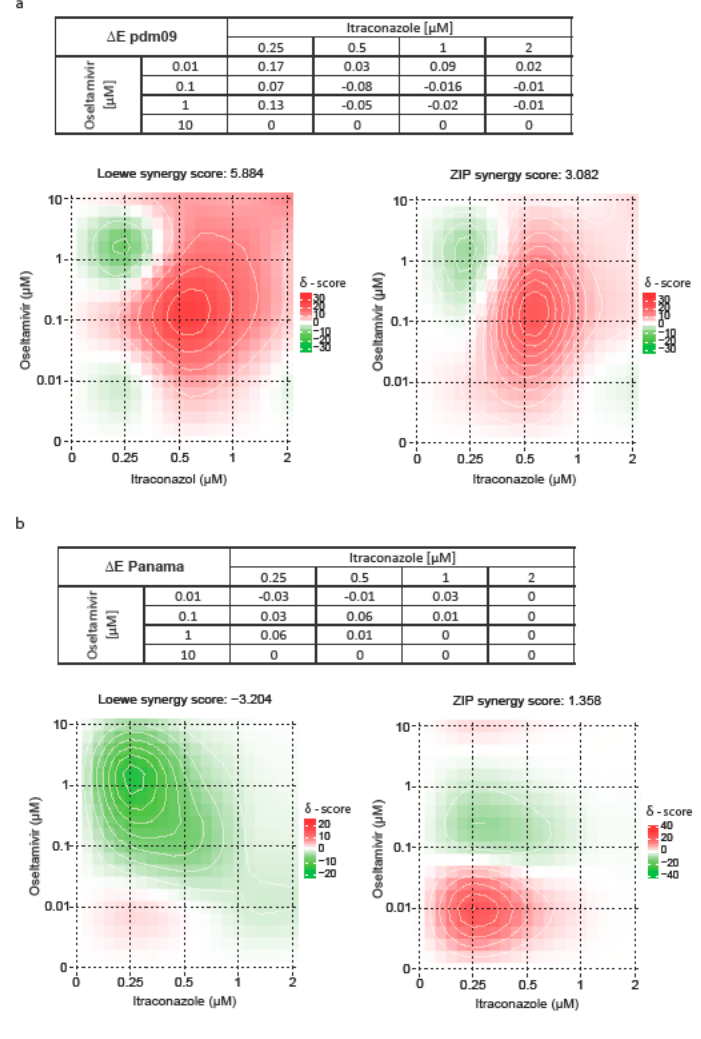
Figure 9. Assessment of synergistic e ff ects of combined treatment with oseltamivir and itraconazole. Bliss independence, Loewe additivity and ZIP reference models were used to assess drug interaction profiles for ( a ) pdm09 and ( b ) Panama virus infections. Bliss independence model, ∆ E < 0 indicates synergism, ∆ E > 0 indicates antagonism. Loewe and ZIP synergy scores, color scale bars indicate mode and strength of